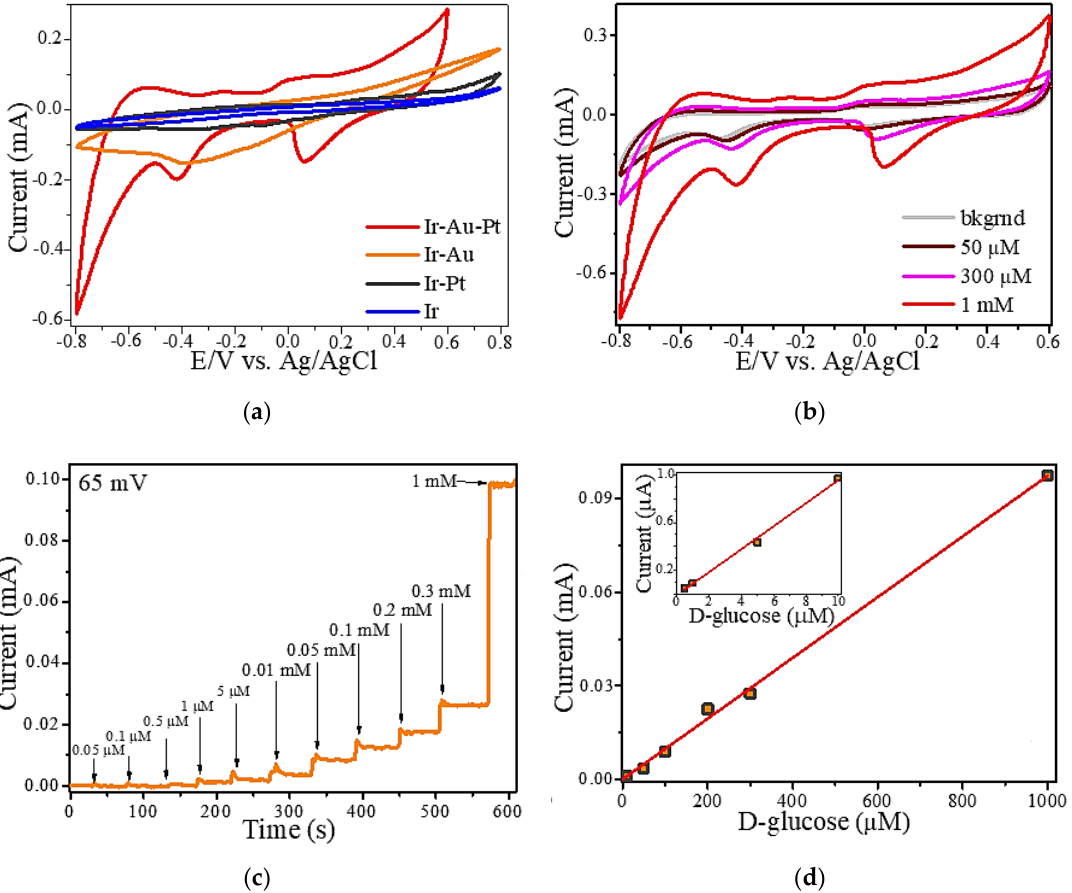
Figure 4. Cyclic voltammograms (CVs) of microstructures based on iridium, gold and platinum recorded in 0.1 M NaOH containing 1 mM D-glucose ( a ). CV of Ir-Au-Pt recorded in 0.1 M NaOH with different concentration of D-glucose ( b ). Amperogram of Ir-Au-Pt obtained in 0.1 M NaOH with different concentration of D-glucose ( c ). Linear dependence of the measured Faraday current on the D-glucose concentrations ( d ).